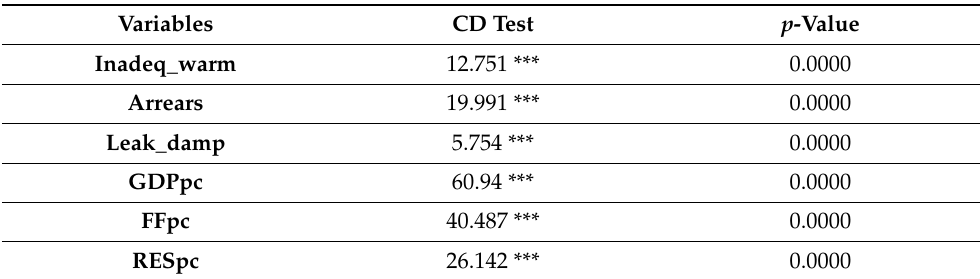
Table 3. Pesaran CD test for cross-section